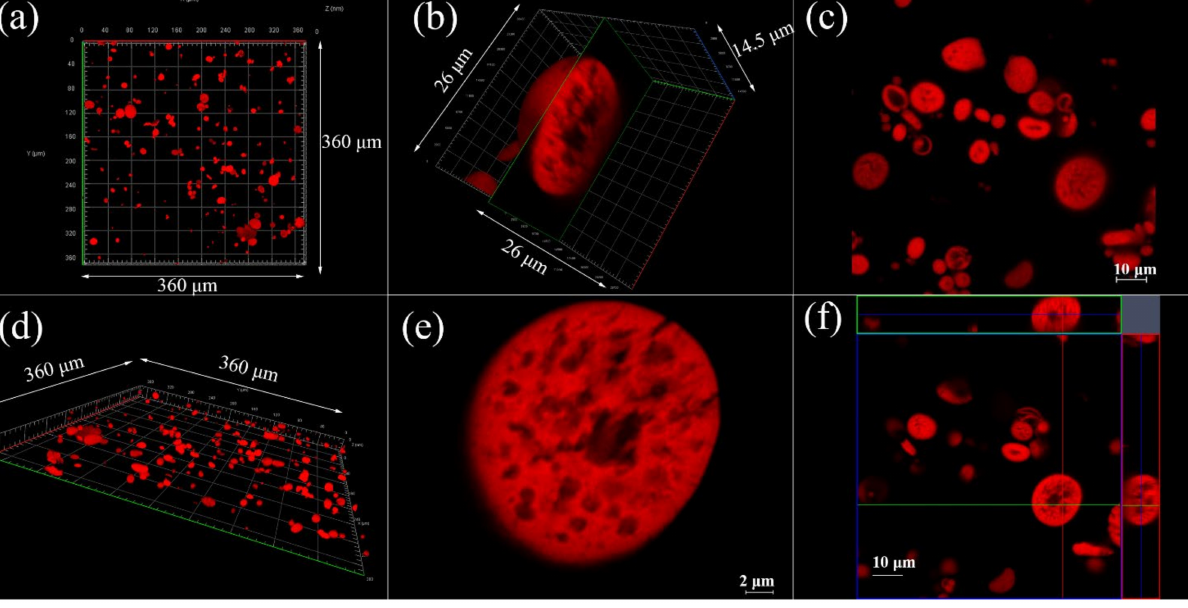
Figure 9. Confocal microscopy images of PCL-b-PLA porous microspheres: ( a ) top view; ( b ) internal view; ( c ) single view; ( d ) 3D view; ( e ) slice view; and ( f ) ortho